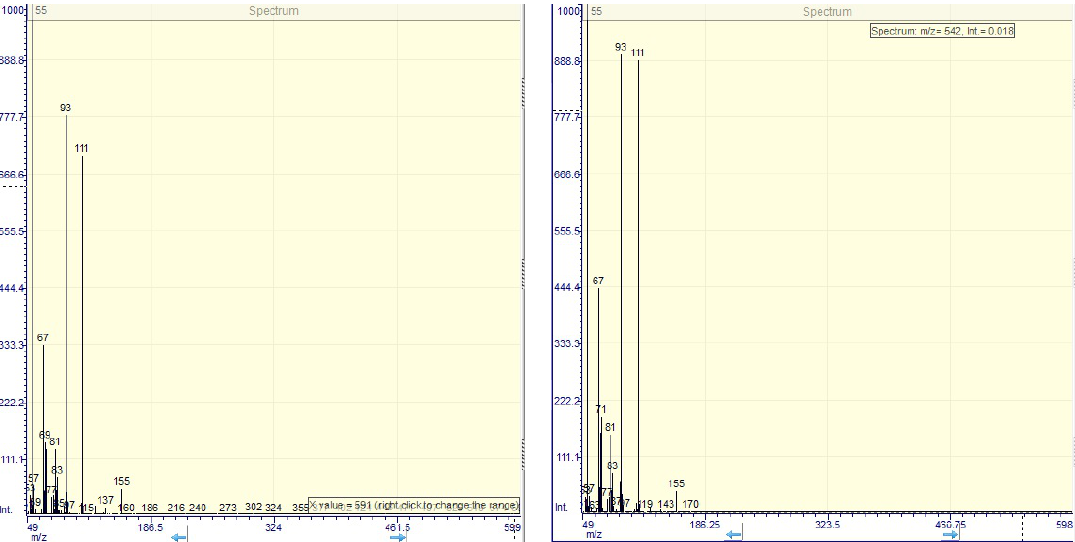
Figure 2. The MS spectra of lilac alcohol C ( left ) and D ( right ) separated from Syringa vulgaris flowers extract.